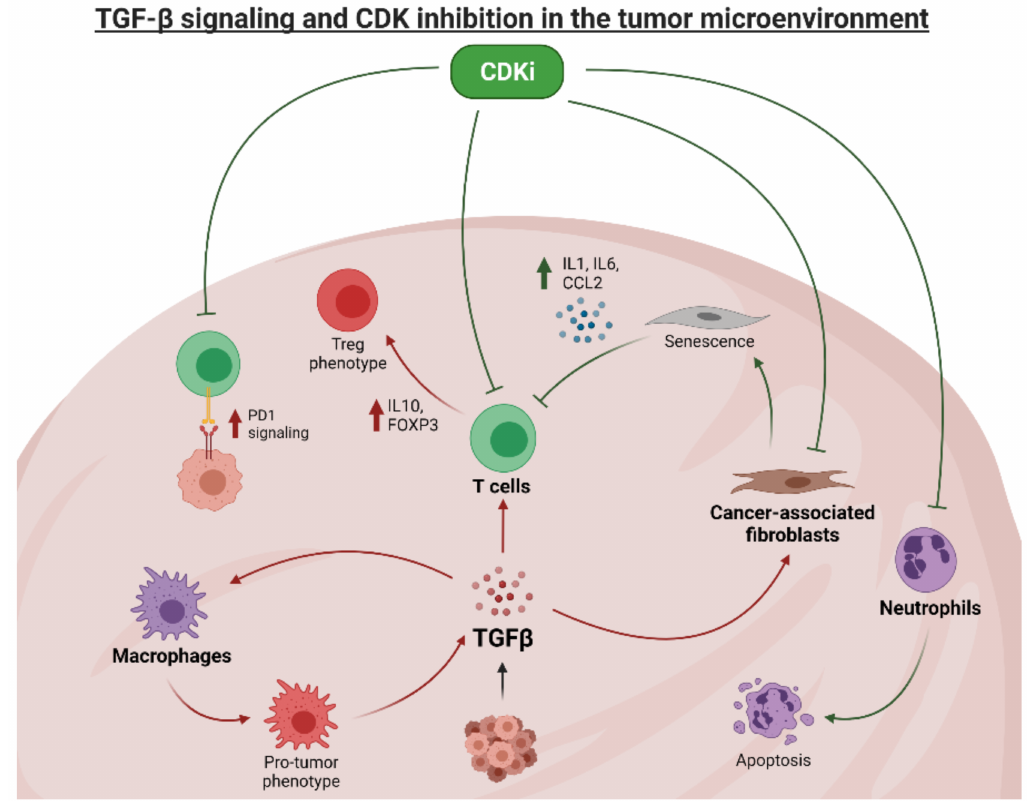
Figure 3. TGF β signaling and CDK inhibition affect the breast cancer microenvironment. Image generated using